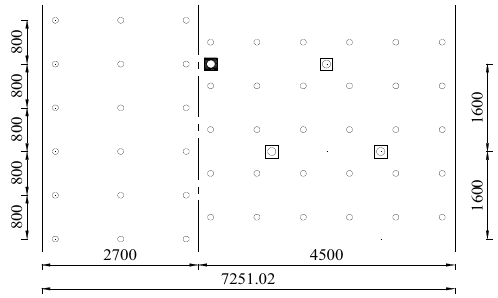
Figure 11. Schematic of safe gap production and support.